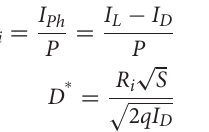
FIGURE 2 | Optoelectronic properties of DSM/PbPc thin film heterojunction photodetectors. (A,D) I-V curves of Cd 3 As 2 /PbPc and (Cd 1 thin film heterojunction photodetectors, respectively, without and with 808nm irradiation. (B,E) Photocurrents of different wavelengths for Cd 3 As 2 /PbPc and (Cd 1 Zn x ) 3 As 2 /PbPc thin film heterojunction photodetectors. The measurements were conducted under bias voltage of − x (C,F) The photocurrent curves of the Cd 3 As 2 /PbPc and (Cd 1